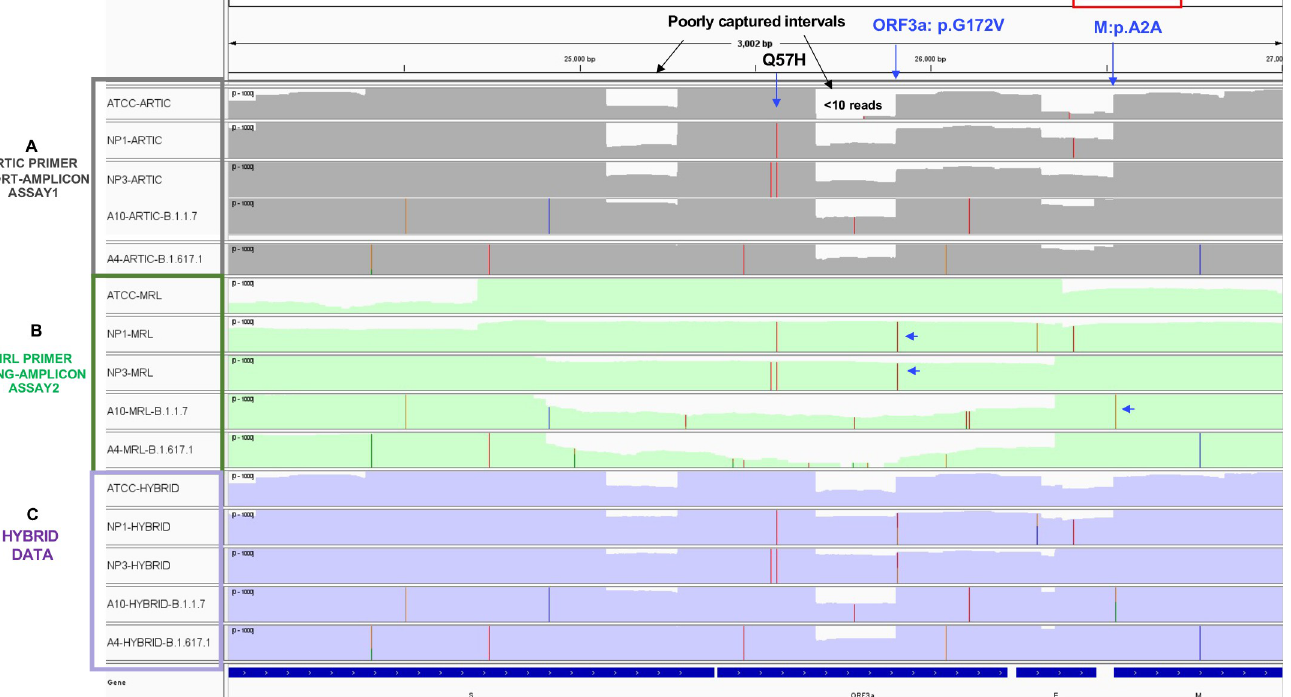
PLOS ONE | https://doi.org/10.1371/journal.pone.0261014 January 13,